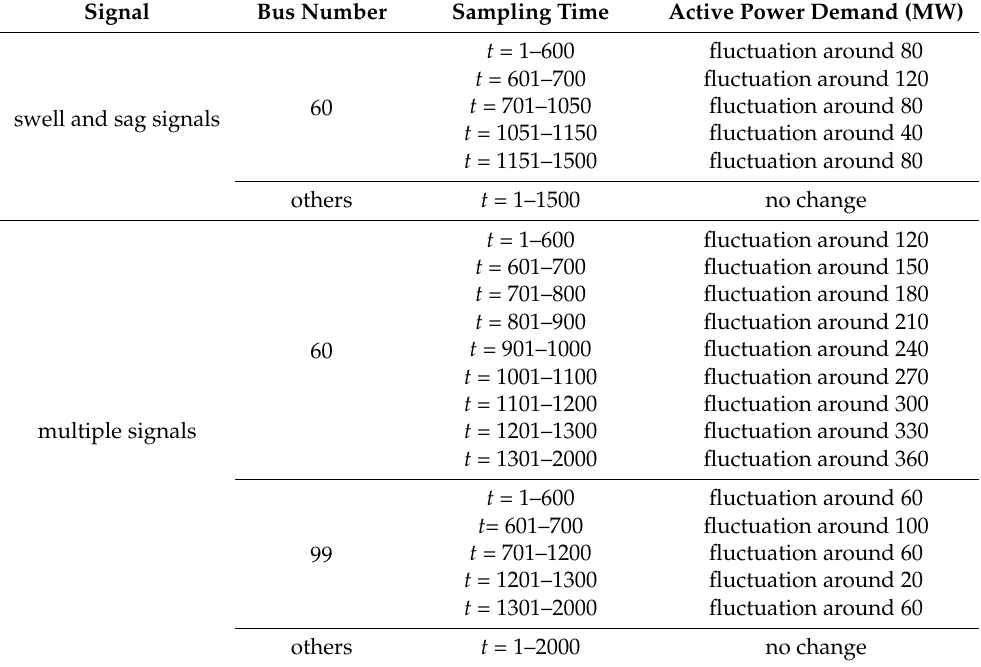
Table 4. Defined signals for event